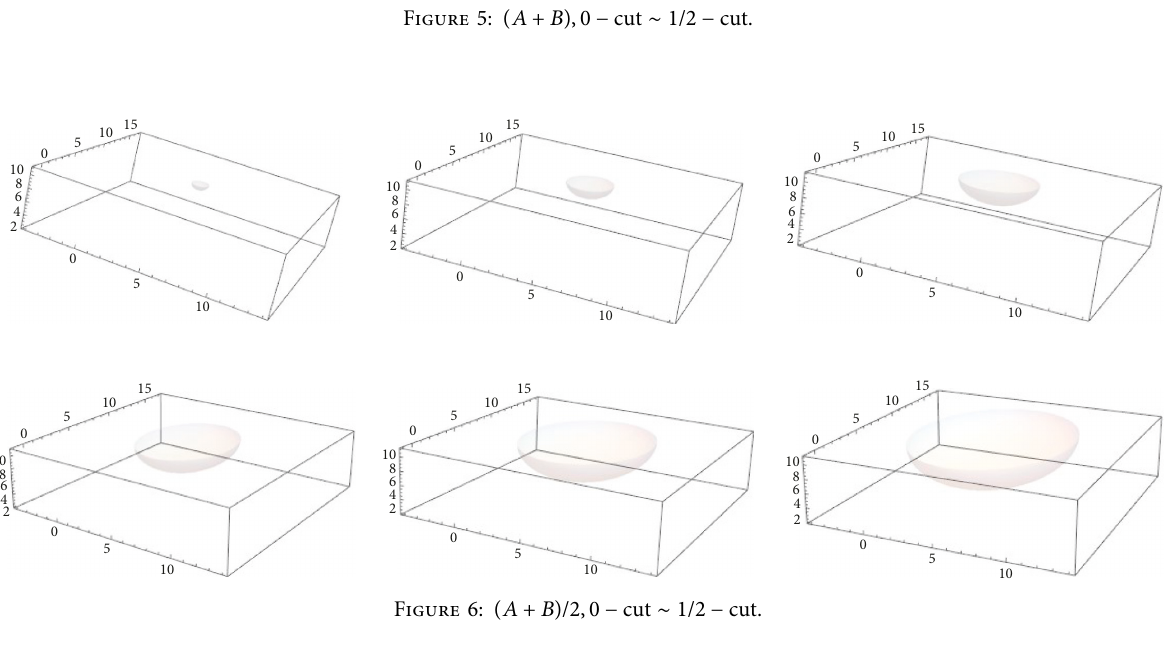
Figure 6: ( A + B ) /2 , 0 − cut ∼ 1/2 − cut.